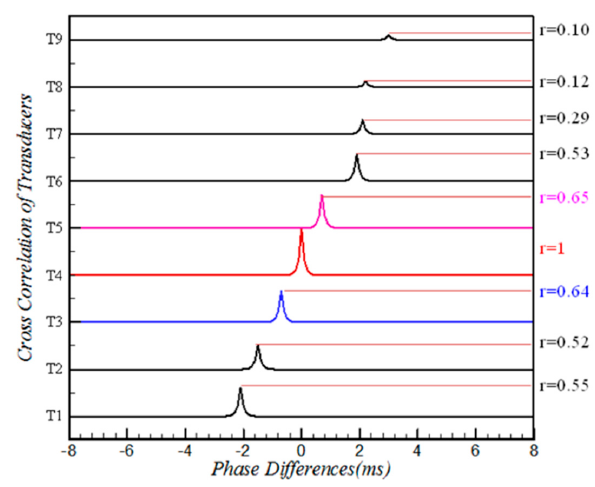
Figure 15. Phase analysis of T1–T9 ( t = 4.5 s).